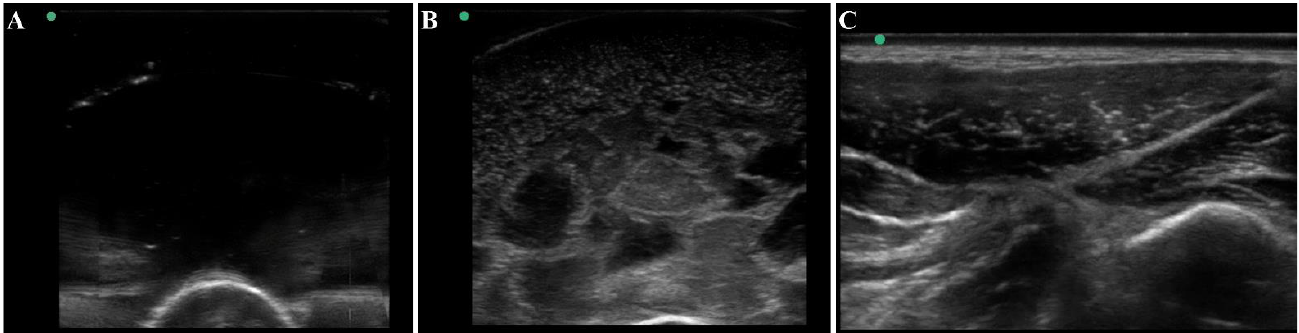
Figure 4. Ultrasound view of the tissue phantom compared to swine tissue. Representative ultra- sound images for ( A ) plain gelatin phantom with no additional components, ( B ) the developed tissue phantom with evaporated milk, flour, and agarose fragments, and ( C ) swine tissue.